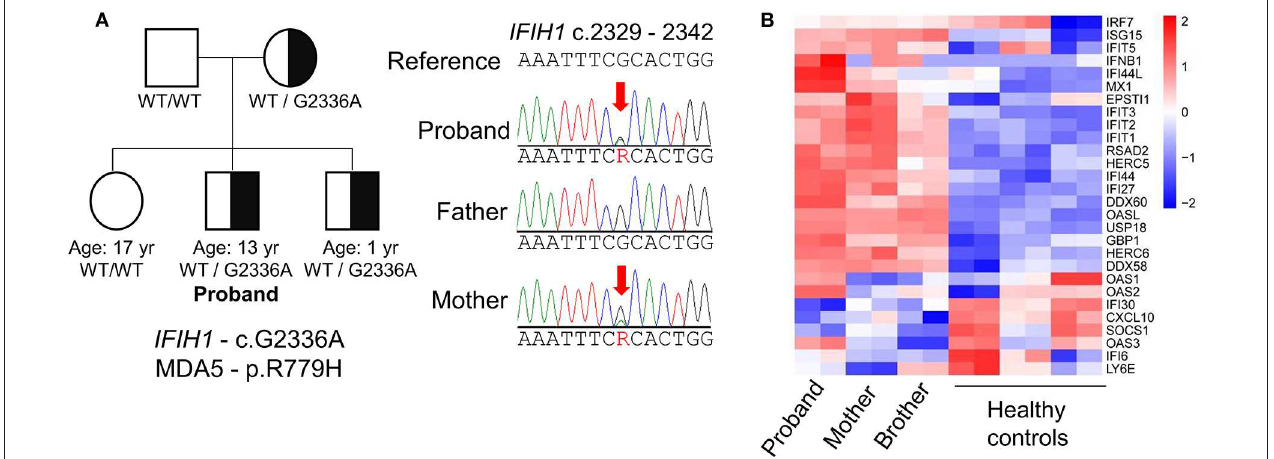
FIGURE 2 | Genetic evaluation of Aicardi-Goutières syndrome. (A) Identification of a missense mutation in IFIH1 by whole-exome sequencing and pedigree of the patient’s family. The proband shares the pathogenic mutation with his mother and younger brother. (B) Heat-map of RNA sequencing analysis illustrates upregulation of IFN-I-inducible genes in the proband compared to healthy controls. The mother and brother display a milder interferon signature compared to the